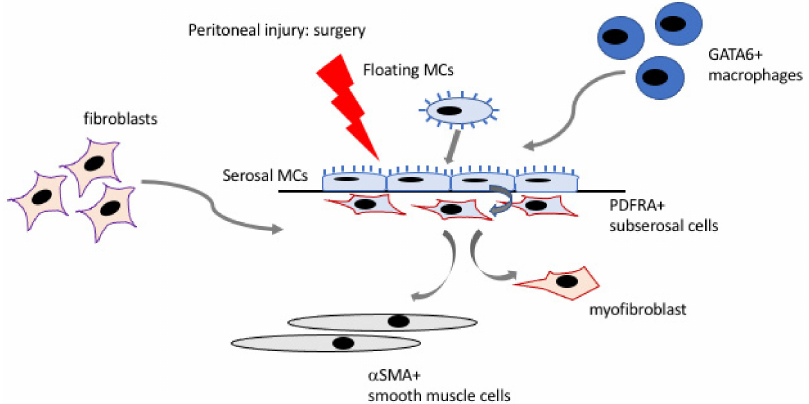
Figure 1. Schematic demonstrating the different cellular contributions to adhesion